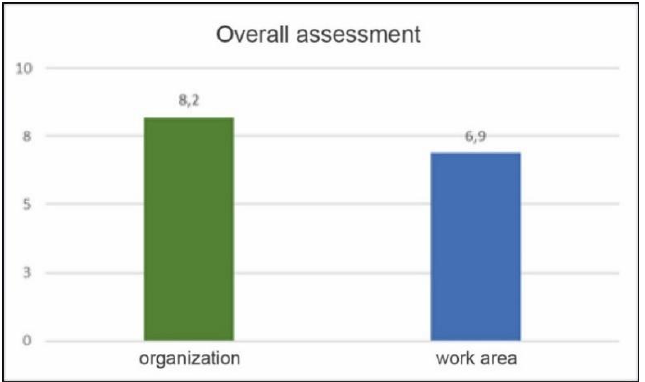
Figure 16. Overall assessment.